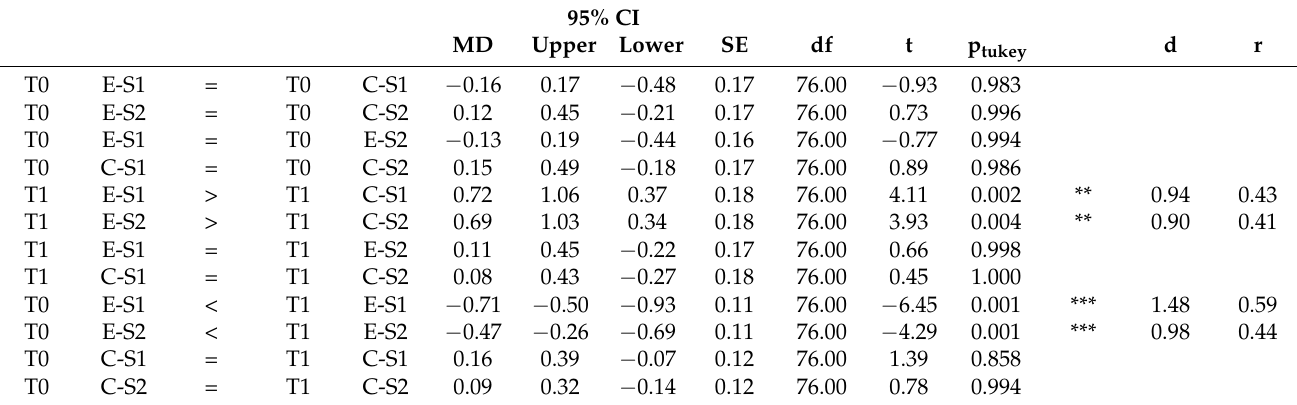
Table 5. Sample 1 and 2 post hoc comparison for CHIME score to test effect